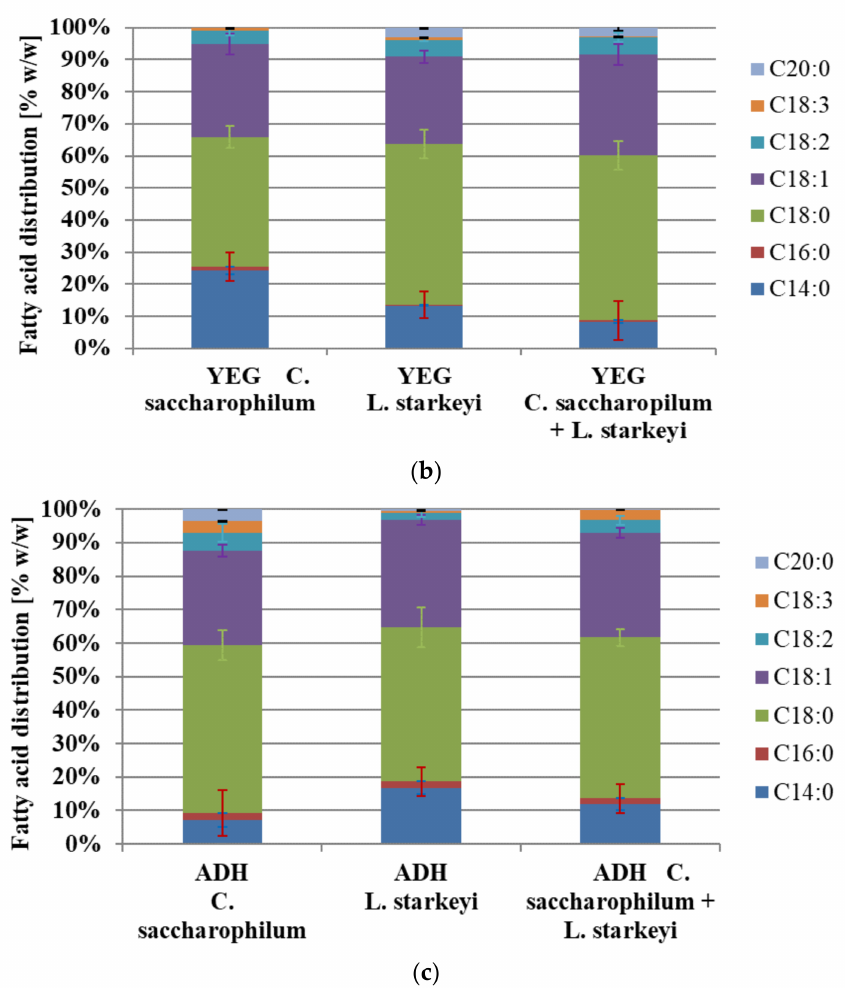
Figure 5. ( a ) Fatty acid distribution (% w / w ) in microbial biomass (individual and mixed cultures) in BBM + G media. ( b ) Fatty acid distribution (% w / w ) in microbial biomass (individual and mixed cultures) in YEG media. ( c ) Fatty acid distribution (% w / w ) in microbial biomass (individual and mixed cultures) in ADH